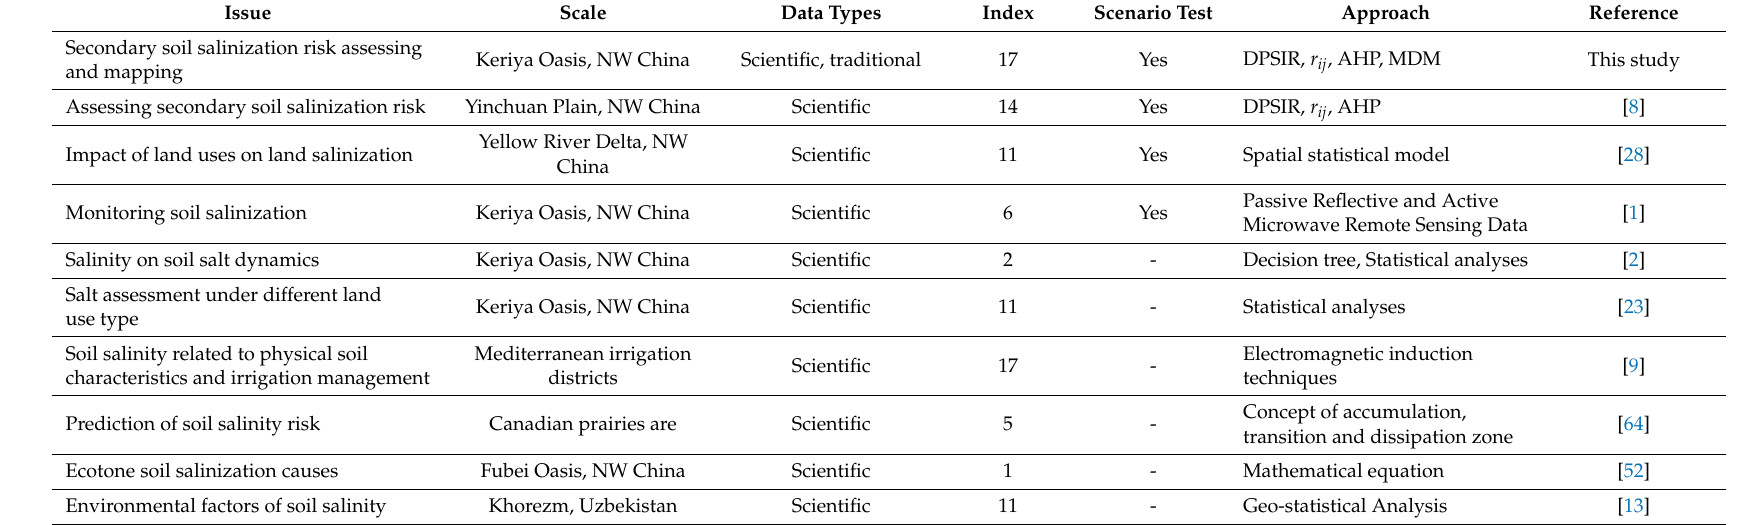
Table 4. Properties of the related issues of secondary soil salinity assessment and mapping compared with the presented